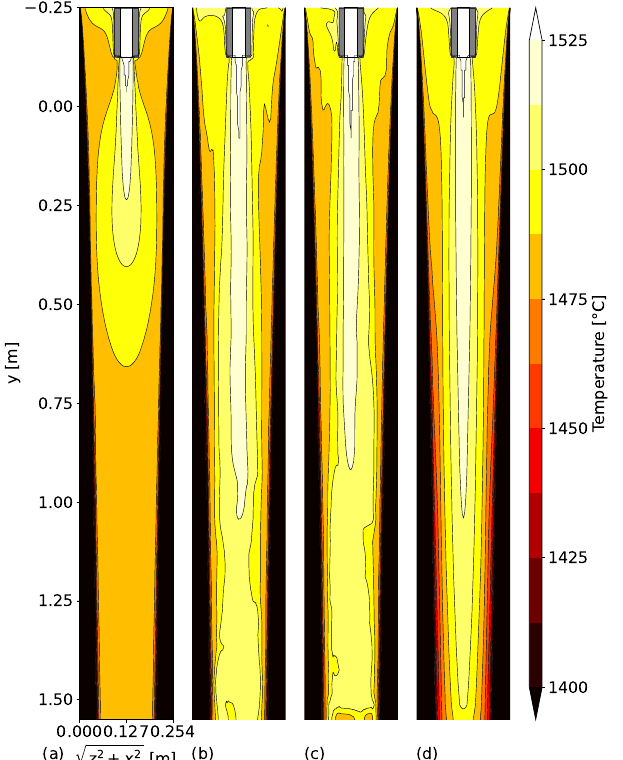
Figure 9. Temperature field at VA3. ( a ) k − ε model; steady-state; ( b ) LES model at t 1 = 205 s; ( c ) LES model at t 2 = 1096 s; ( d ) LES model;